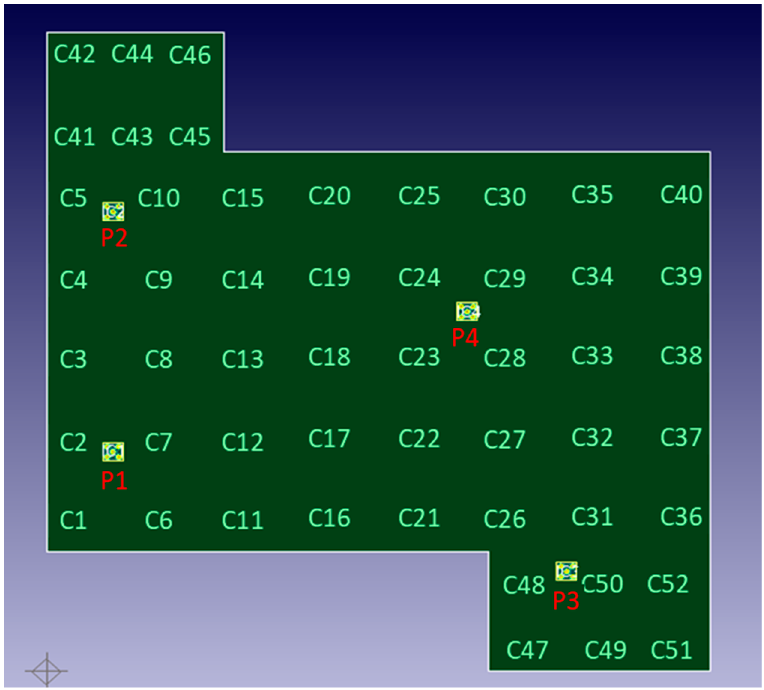
Figure 3. Schematic of the power delivery network (PDN) board: position of the 4 ports (P1 to P4) and grid of the allowed positions of the decaps.